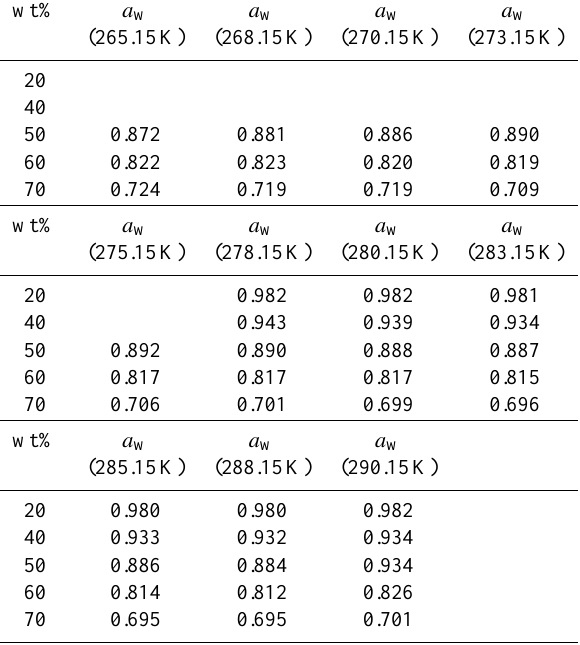
Table 16. Measured water activities of water (1)+M5 (2) mixtures derived from total gas phase pressure measurements ∗ , listed for a selection of temperatures in the range 265K <T < 291K. The total organic mass fraction of the solution is given in the first